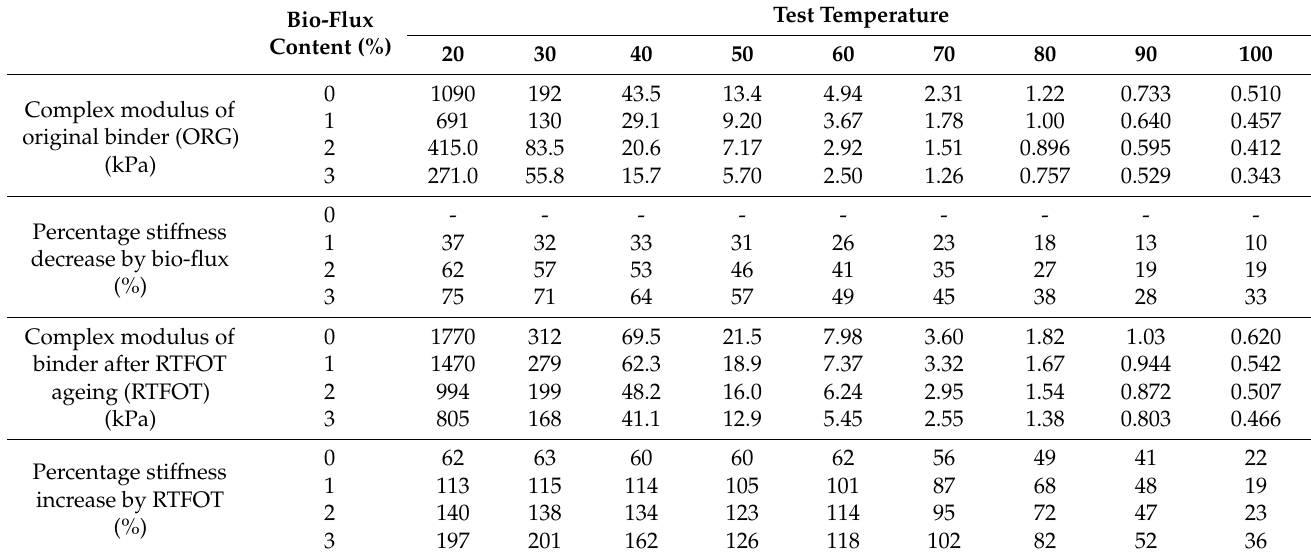
Table 5. Comparison of G* modulus results in 20 ◦ C of the 45/80–80 highly modified